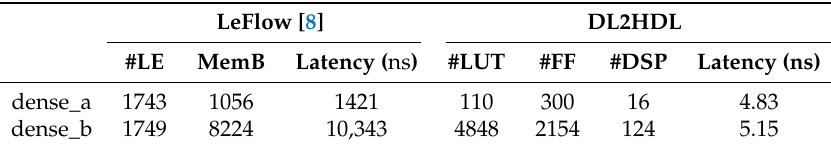
Table 8. Comparison with the LeFlow